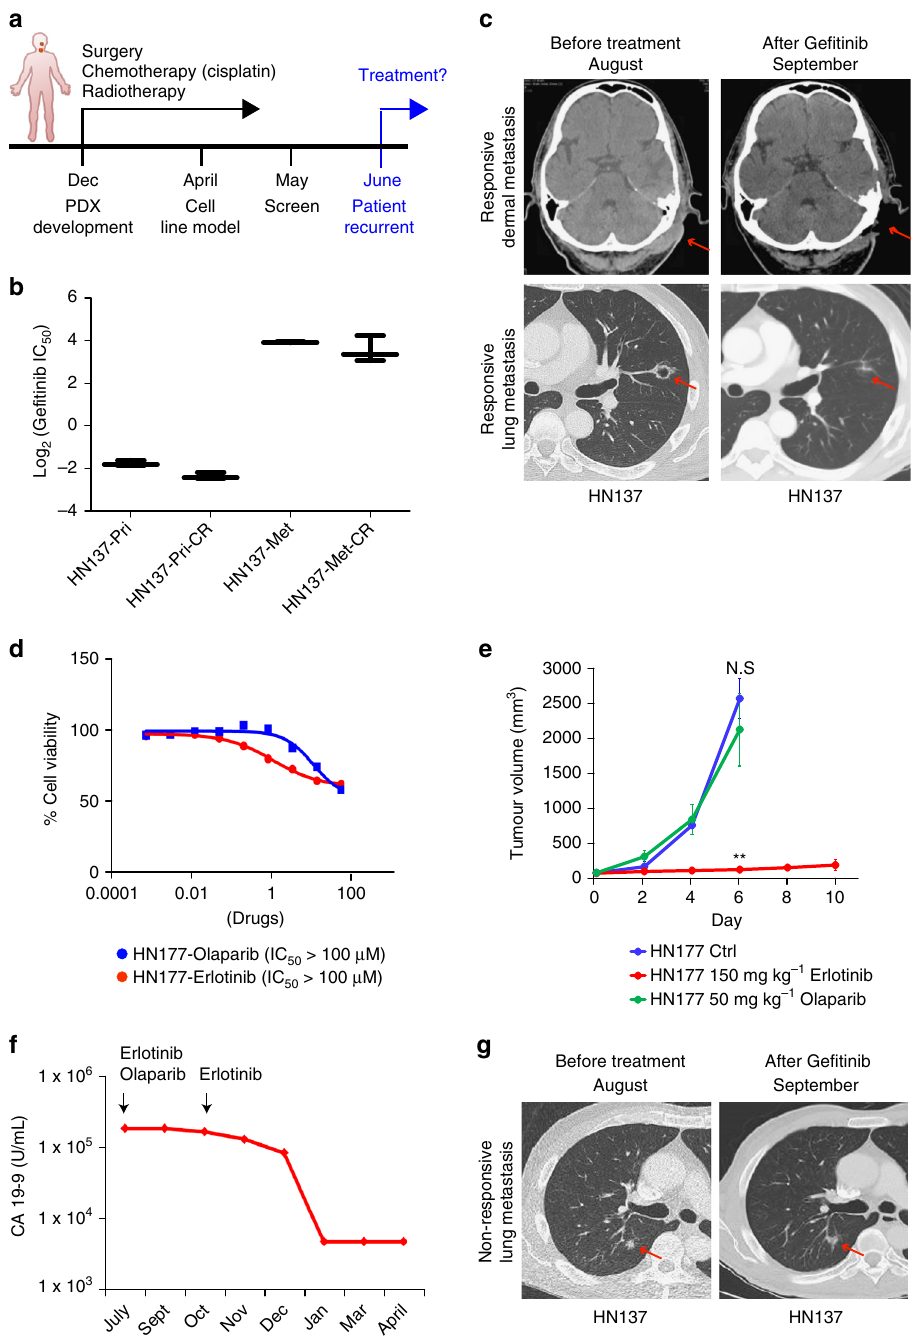
Fig. 3 PDC/PDX-guided treatment of patients under two independent n = 1 co-clinical trials. a Timeline for patient HN137 from surgery (December), adjuvant chemo-radiation therapy, until tumour recurrence in June. b Graph denoting Log 2 (IC 50 ) values of HN137-Pri, HN137-Pri cisplatin resistant (CR), HN137-Met, HN137-Met cisplatin resistant (CR) cell lines in the presence of ge fi tinib. c Computed tomography scan (CT-scan) of recurrent responsive metastatic sites (dermal metastasis ( top panel ) and lung metastasis ( bottom panel )) in HN137 patient, before and after treatment with 250 mg per day of ge fi tinib. Arrows denote sites of tumours before and after treatment. d Dose response of HN177-PDC to erlotinib and olaparib. Cell viability was determined using CellTiter-Glo reagent. Triplicate data, error bars represent mean ± s.d. e Three independent cohorts of mice ( n = 2 for control and n = 3 for treated) bearing HN177-PDX in one fl ank were treated with vehicle control (Ctrl), 50 mg kg − 1 olaparib and 150 mg kg − 1 erlotinib. Error bars represent mean ± s.e.m. Two-tail Student ’ s t test was carried out between olaparib and control group (N.S.: not signi fi cant) and between erlotinib and control group ** P value < 0.01. f Changes in serum carbohydrate antigen 19-9 (CA 19-9) at initial time of diagnosis and during the course of treatment. g CT-scan of recurrent non-responsive lung metastasis in HN137 patient, before and after treatment with 250 mg day − 1 of ge fi tinib. Arrows denote sites of tumours before and after